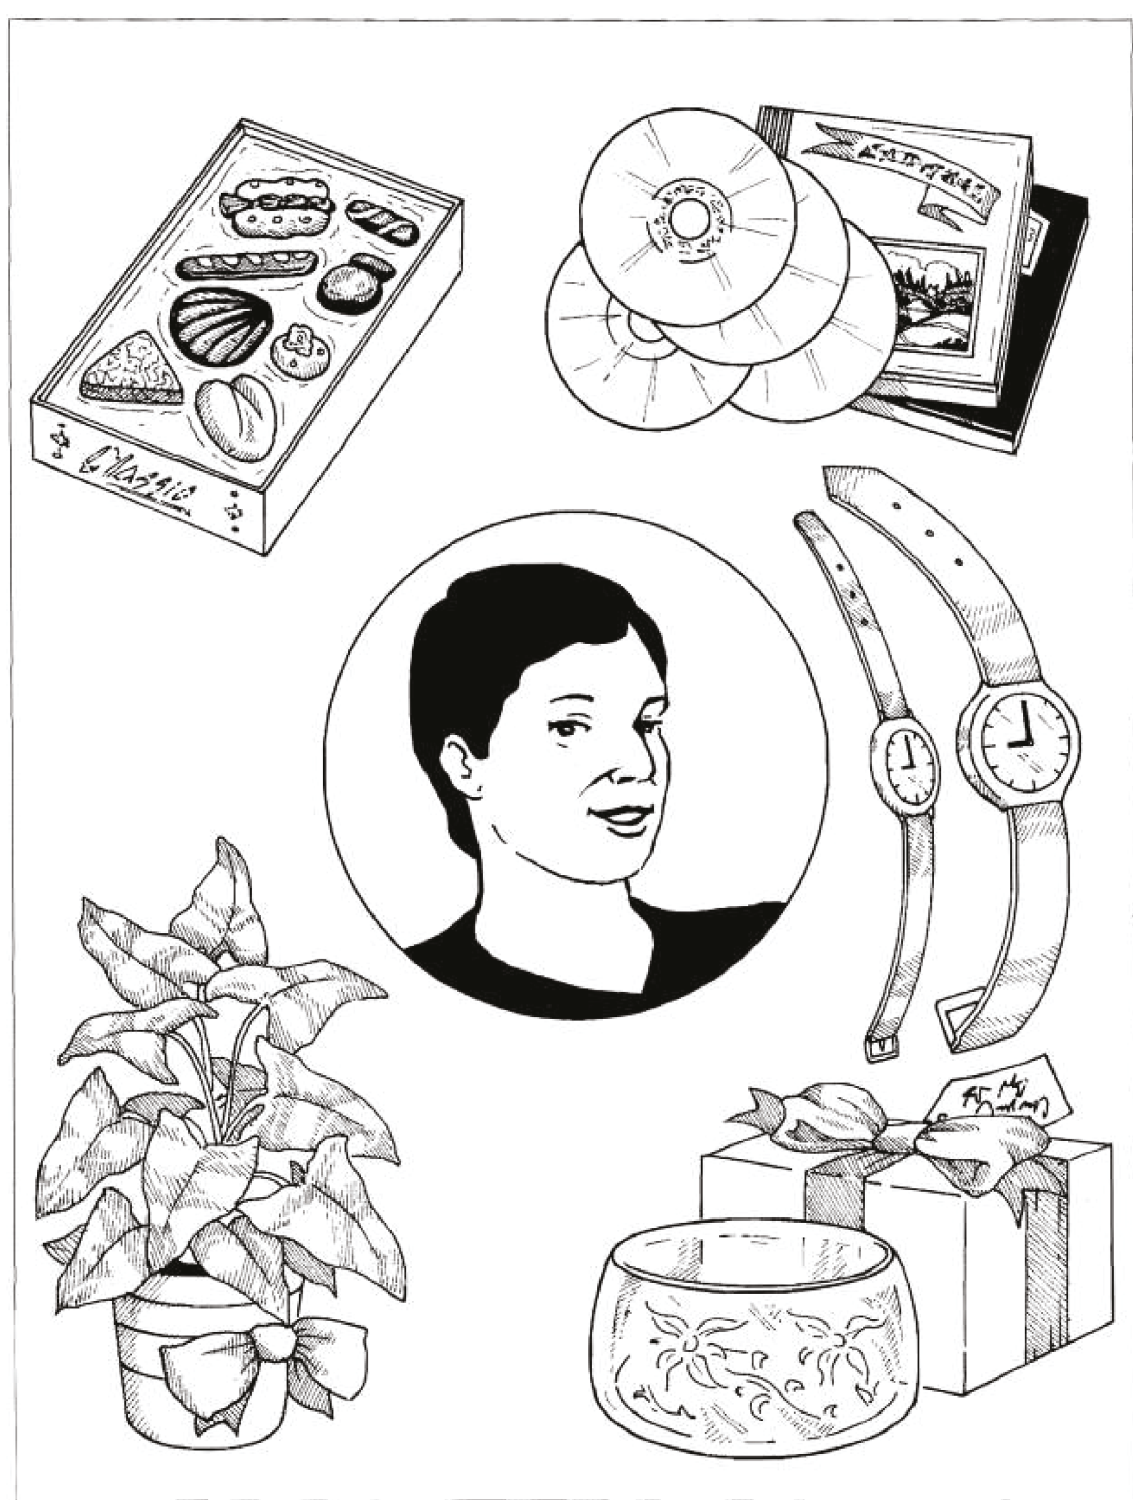
Figure 2: Pre-test page